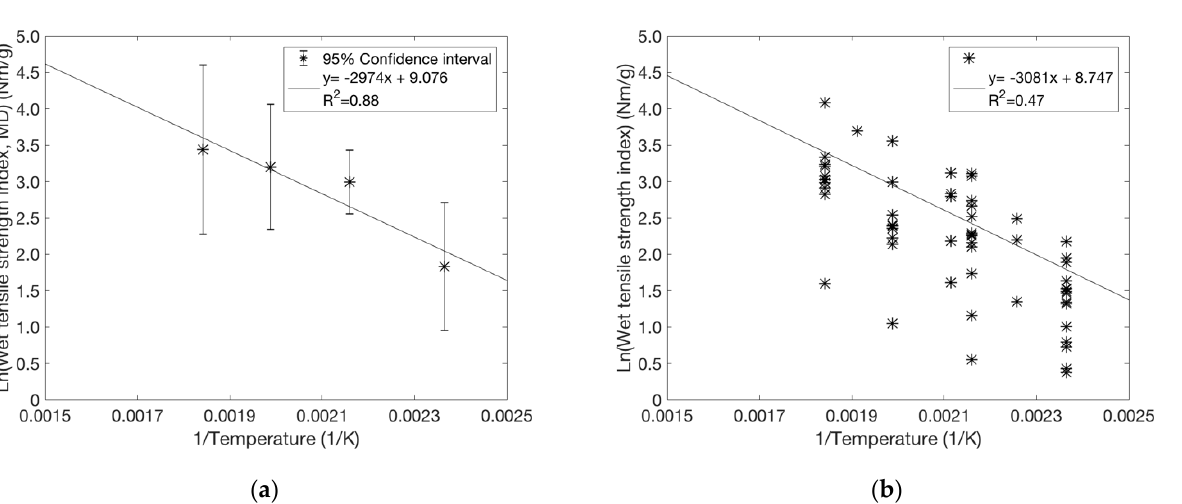
Figure 7. The apparent activation energy (left vertical axis) and extrapolated ln(Wet tensile strength index) at 1/T = 0 (right logarithmic axis) for different pulps with varied lignin content. The extrapo- lation omits the degradation of fibre-wall polymers and therefore does not describe the true high- temperature limit of wet tensile index. The points up to 12% lignin content describe kraft pulps with varied cooking times in pulping. These results are compared with similar data for CTMP and TMP with lignin content of 26–28%.